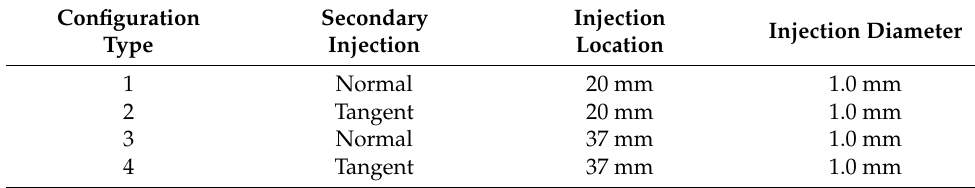
Figure 3. Gas generator configurations: ( a ) normal injectors; ( b ) tangent injectors. Table 3. Gas generator configurations for computational simulations.